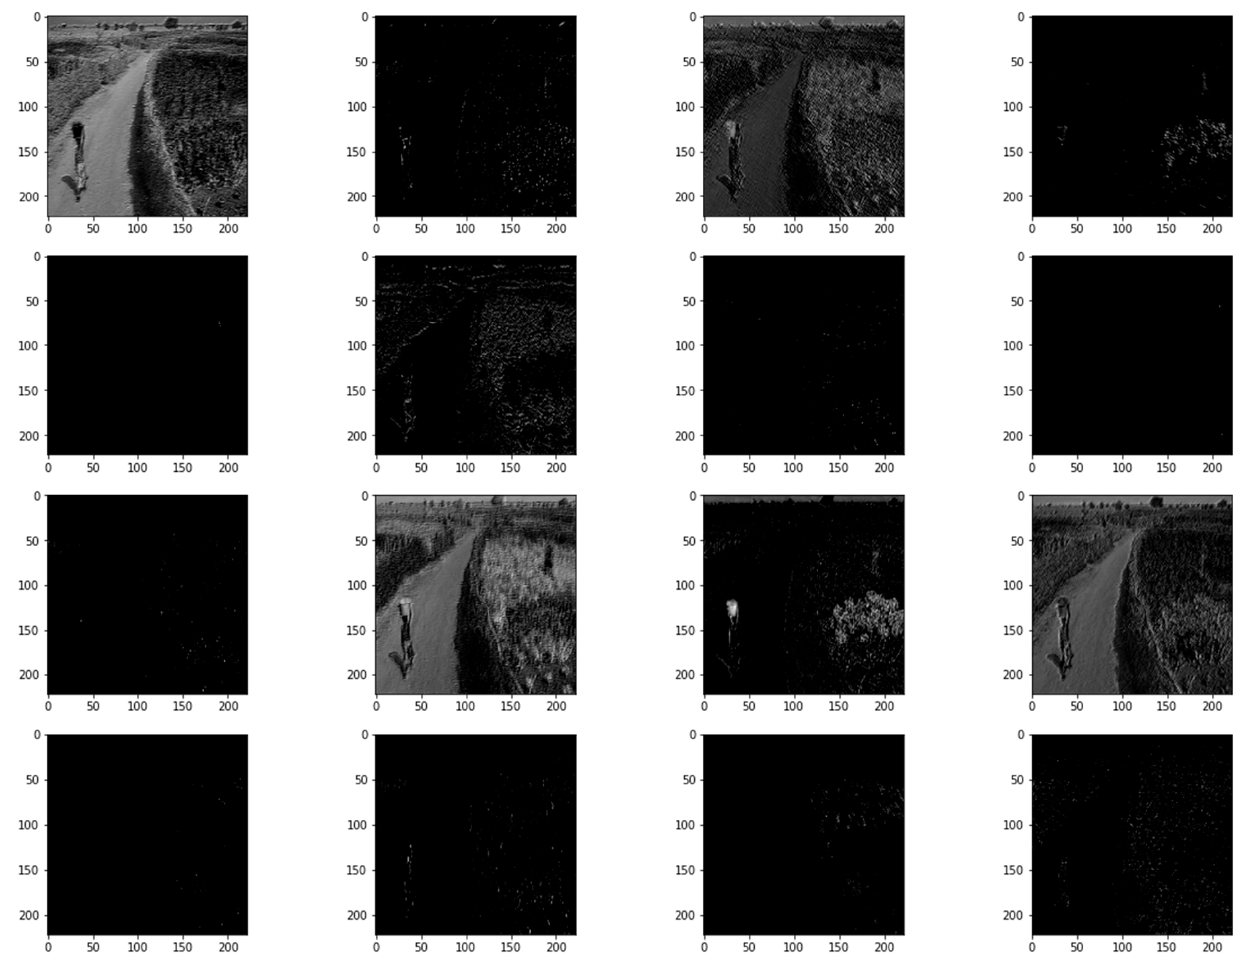
Figure 5. Feature map for a forgery image from a CASIA 1.0 dataset.